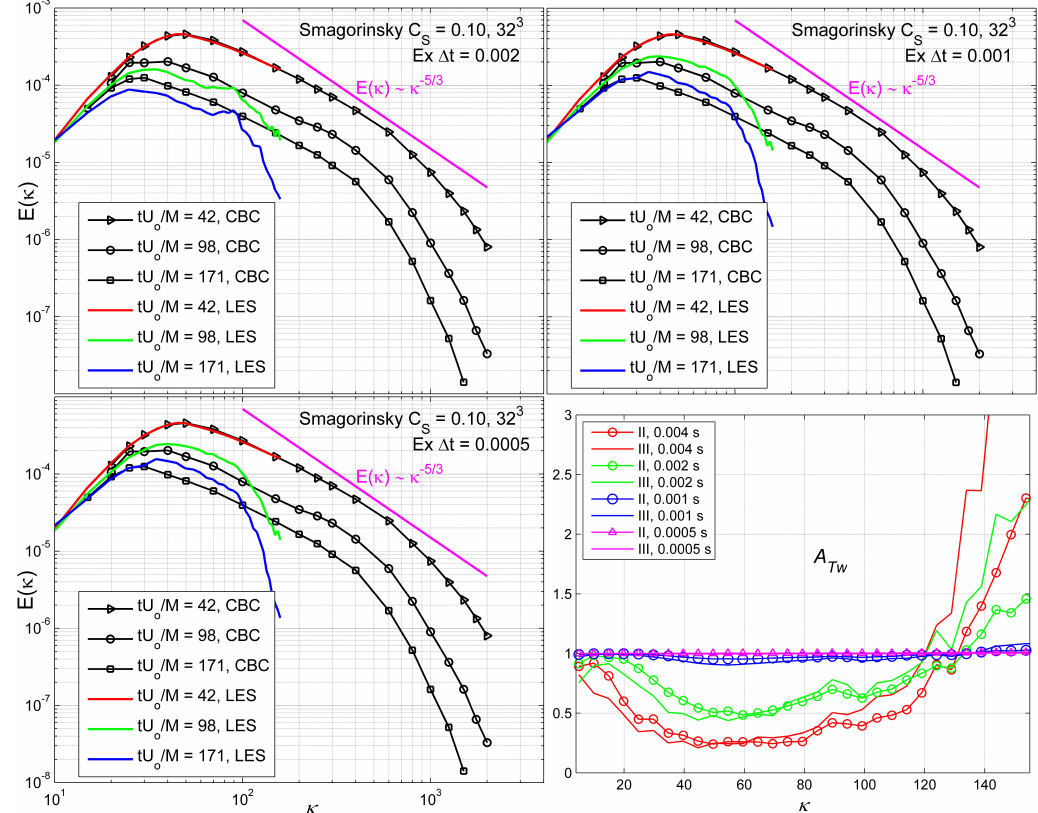
Figure 5. Energy spectra obtained using C S = 0.1 on a 32 3 grid with the Ex4 and different time